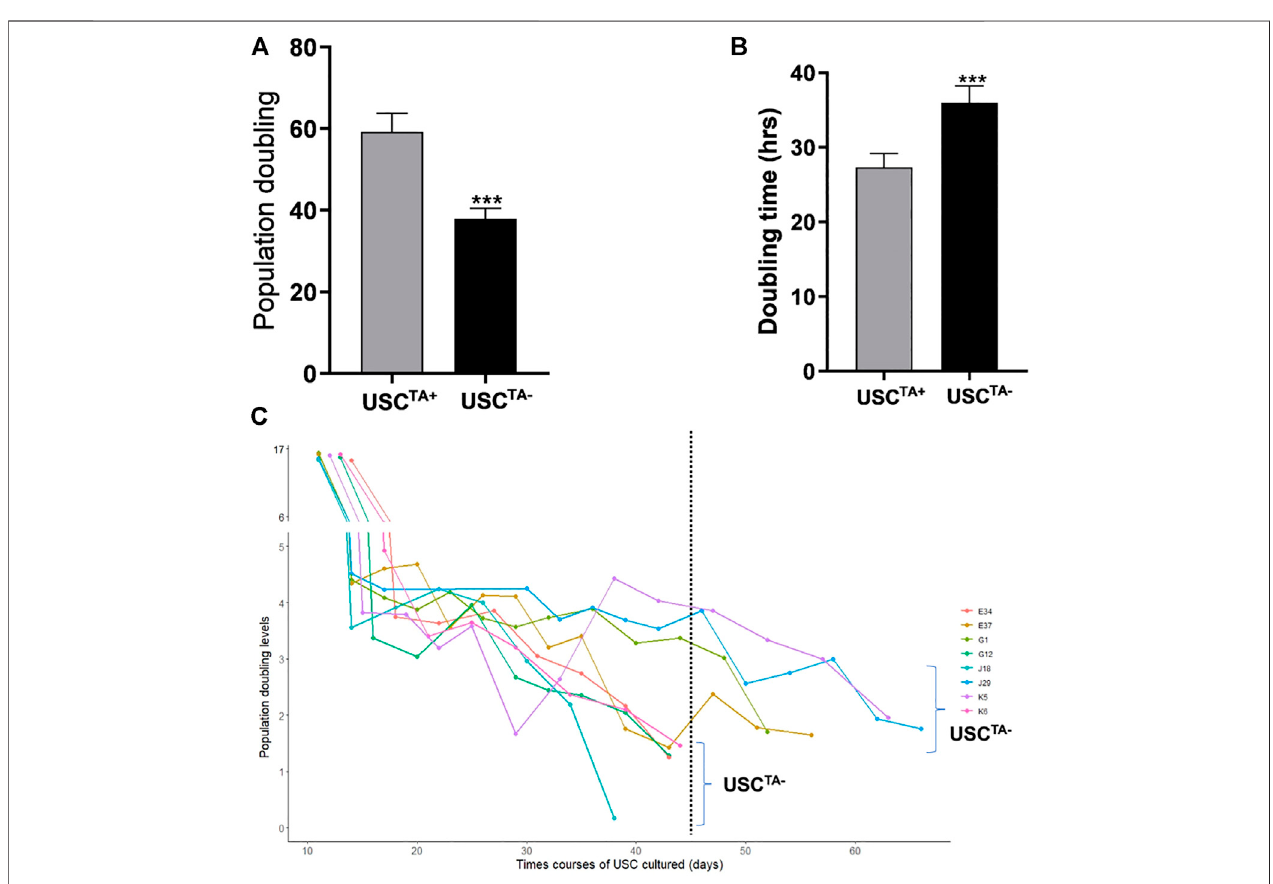
FIGURE 5 | Population doubling, doubling time, and in vitro survival time course of USCs TA+ vs USCs TA − . (A) Population doubling signi fi cantly increased for USCs TA+ comparedtoUSCs TA − . (B) Doublingtimewassigni fi cantlyshorterinUSCs TA+ thaninUSCs TA − . (C) CellularsenescenceinUSCs TA − occurredearlierthanthatin USCs TA+ upon cell expansion. These data indicate that USCs TA+ proliferates more rapidly, generates more cells, and survives longer than USCs TA − . USCs from healthy individuals ( n = 12) were cultured following plating at a single cell/well. Six individual USC TA+ clones ( n = 6, p3, A35, B36, G1, E37, J29, and K5) generated signi fi cantly more cells and grew faster than USC TA − clones ( n = 6, p3, A42, B31, G12, E34, J18, and K6). USC TA+ clones survived longer and had longer population doubling times. The suf fi xes A, B, G, C, H, D, E, F, J, and K represent the ten healthy individuals who participated in the study.